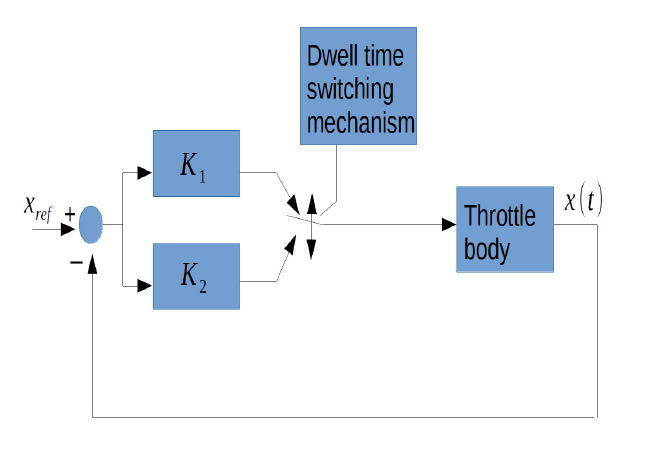
Figure 2. The proposed closed-loop control system.